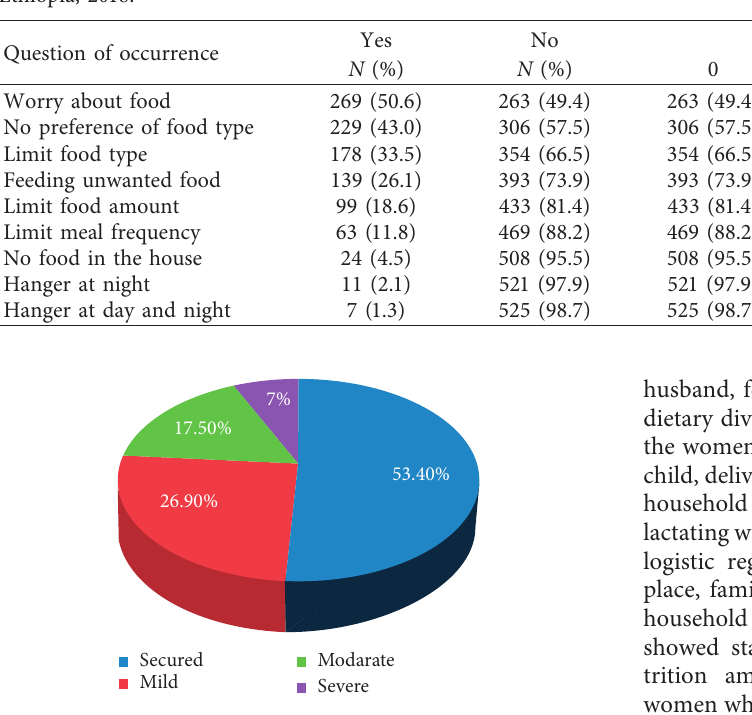
Table 2: Household food insecurity assesses scale questions and response of lactating women ( N � 532) in Moyale District, Borana, Southern Ethiopia, 2018.